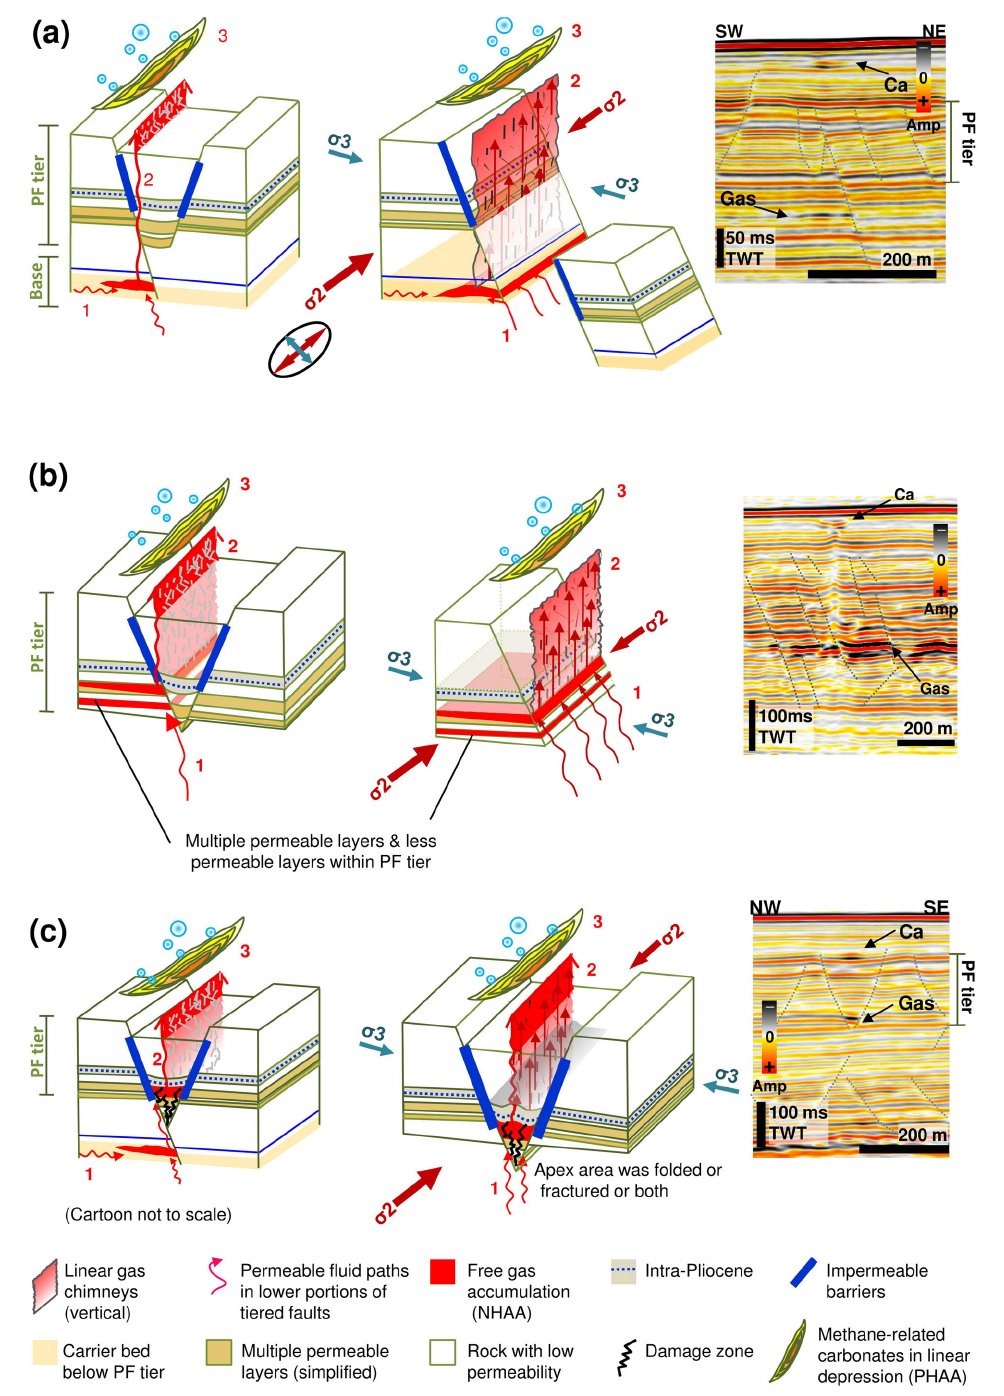
Figure 16. Left column: conceptual models illustrating alternative gas migration pathways through the PF tier. Right column: seismic lines showing the critical observations. Free gas on seismic profiles is expressed by negative high-amplitude anomaly (NHAA), while methane- related carbonates are expressed by positive high-amplitude anomaly (PHAA). (a) Below the PF tier from which Linear Chimneys originate; free gas is trapped by fault-bound traps formed by tectonic faults or deep-rooted PFs. (b) Gas accumulation in the PF-bound traps in the lower part of PF footwalls; note the possible occurrence of multiple permeable layers filled by gas. (c) Free gas trapped by the lower hanging wall of PFs in which accommodation space was created by fractures or fold during